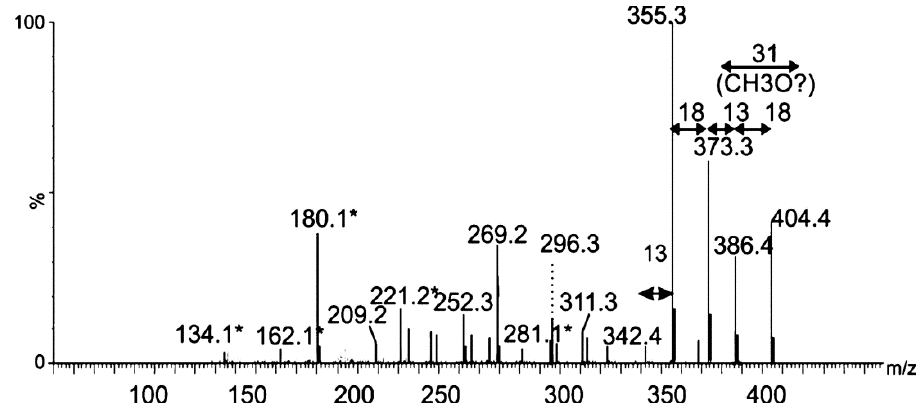
Figure 5. Mass spectrometry analysis of putative glycan oxonium ion. Tandem mass spectrum of singly charged ion at m / z 404 following feCID of intact polar flagellin protein showed consecutive losses of water and methyl groups from the parent ion. Subsequent losses from this ion gave rise to a fragmentation pattern similar to that observed with nonulosonic acid sugars. Daughter ions marked with an asterisk denote those fragment ions found in MS/MS spectra of pseudaminic acid. Figure legend: = 376 Da sugar; * = fragment ions common to pseudaminic acid.